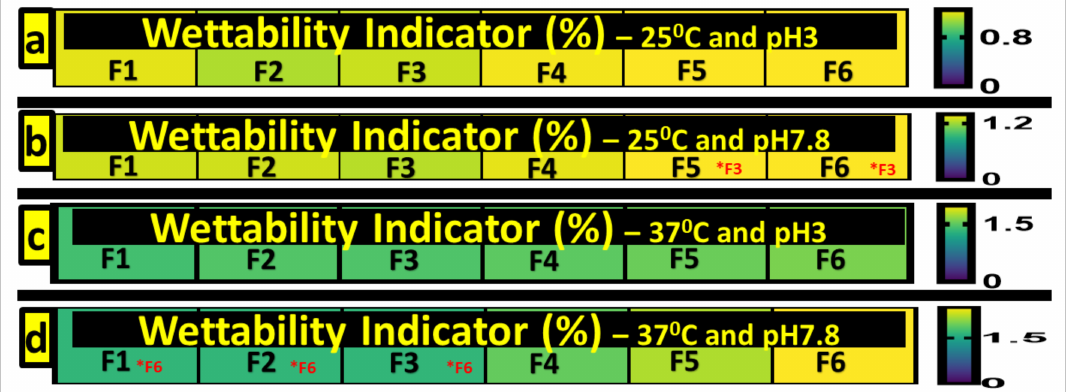
Figure 4. Swelling studies at 25 ◦ C and pH 3 ( a ), 25 ◦ C and pH 7.8 ( b ), 37 ◦ C and pH 3 ( c ) and 37 ◦ C and pH 7.8 ( d ).